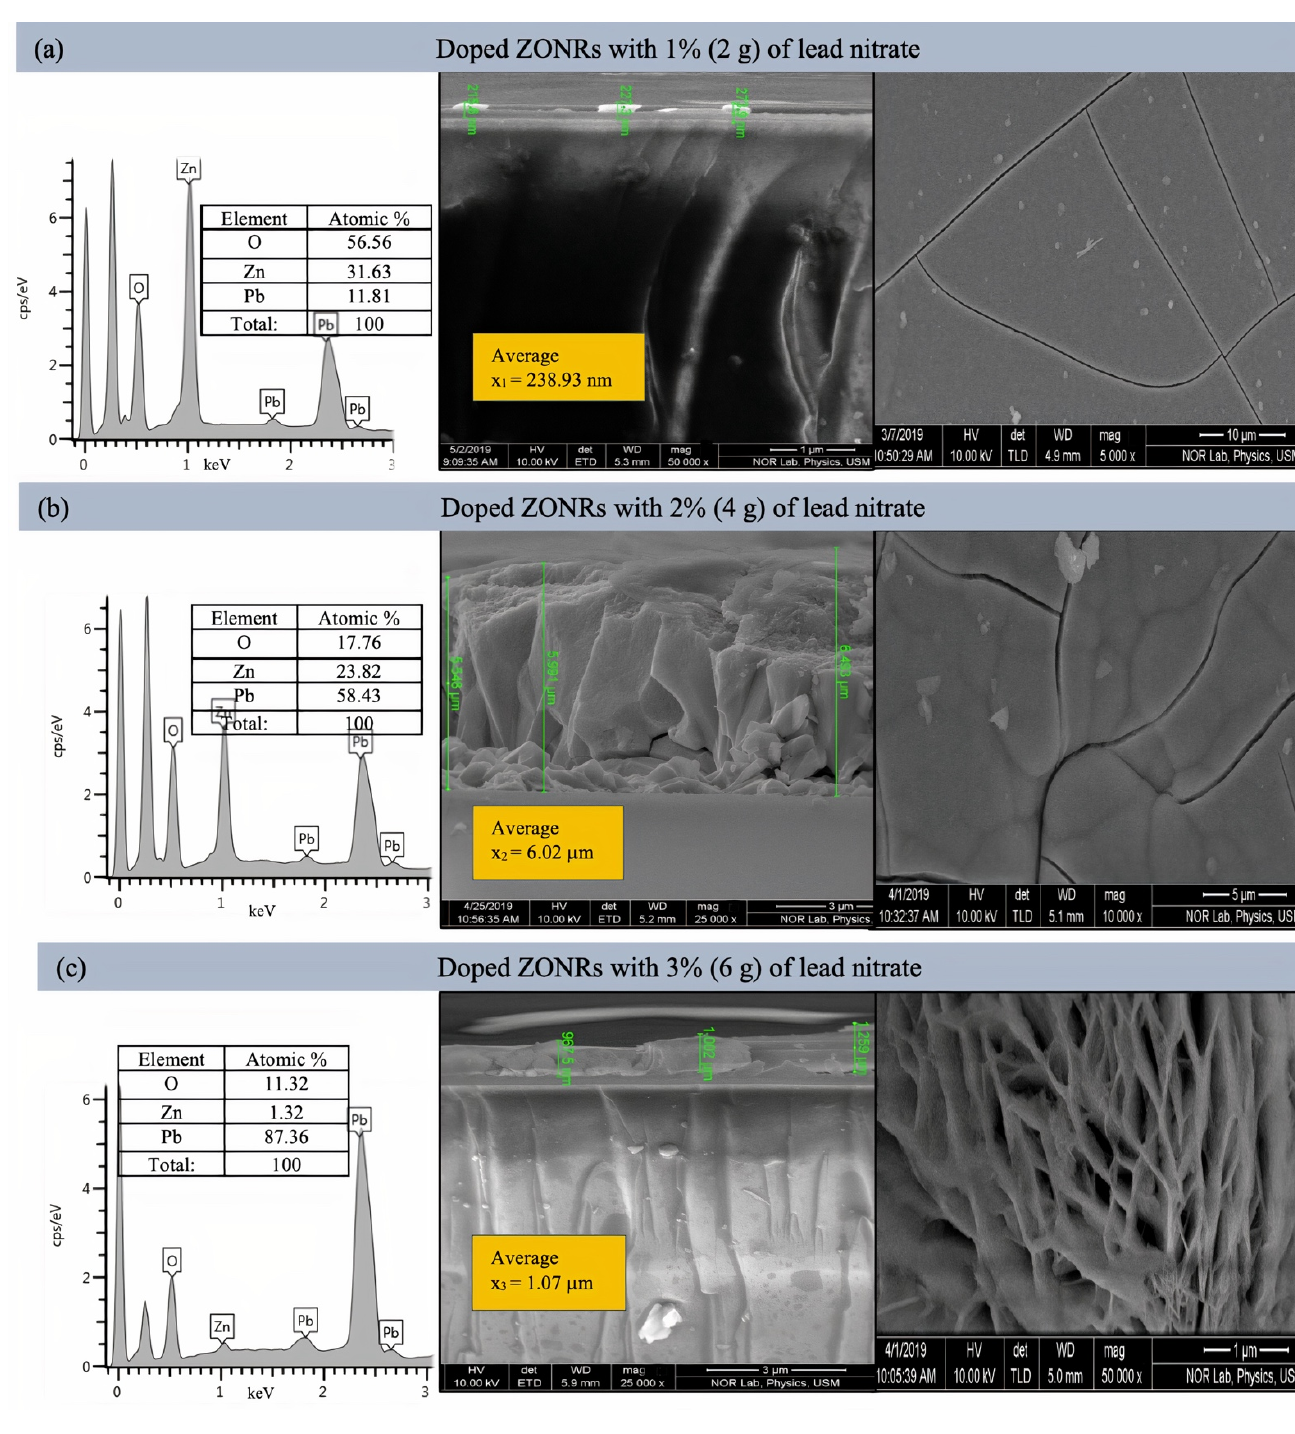
Figure 6. Cross-sectional FESEM images ( right ) and EDX spectra ( left ) of ZONRs-TFs doped with 1–3 wt.% of LN. Inset: EDX Atomic% of detected trace elements.